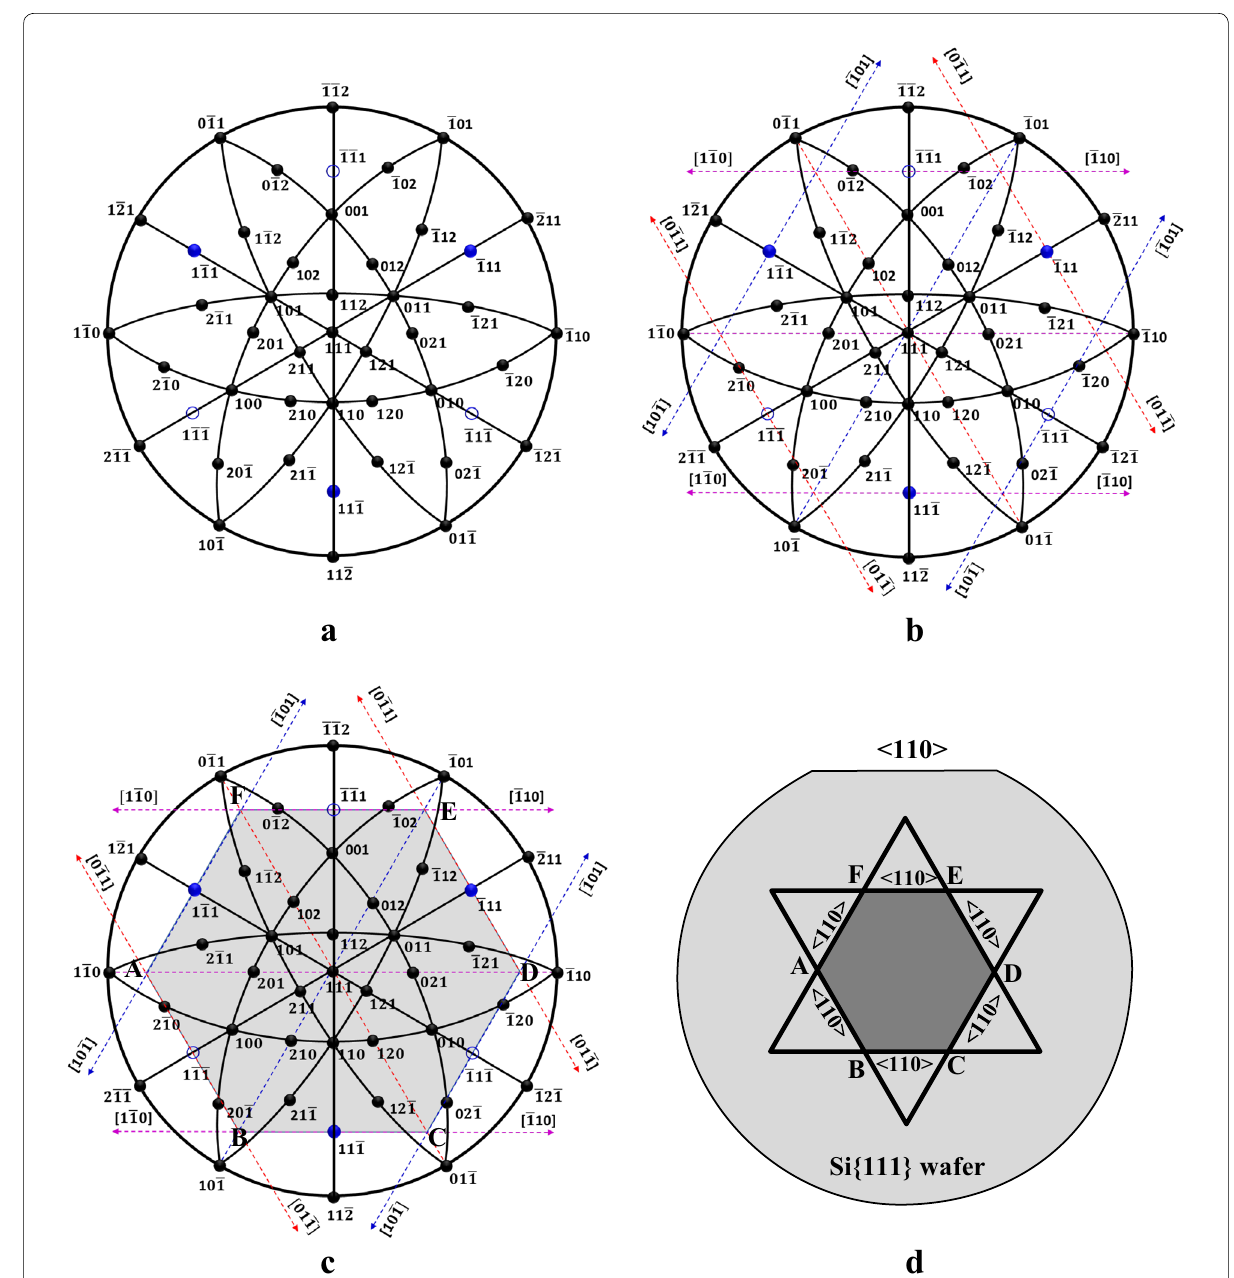
Fig. 1 a Stereographic projection of {111} silicon. The {111} planes projected from the top and bottom hemispheres are shown by solid ( ● ) and open ( ○ ) circles, respectively. b 〈 110 〉 directions at which {111} planes appear during wet anisotropic etching process. c Hexagonal contour formed by the intersection of 〈 110 〉 directions at which {111} planes emerge. d 〈 110 〉 direction at Si{111} wafer surface with primary flat oriented along 〈 110 〉 direction. Three {111} planes ( ● ) are 109.5º to the surface plane and are 60º to each other, while another three {111} planes ( ○ ) are 70.5º to the surface plane and 60º to each